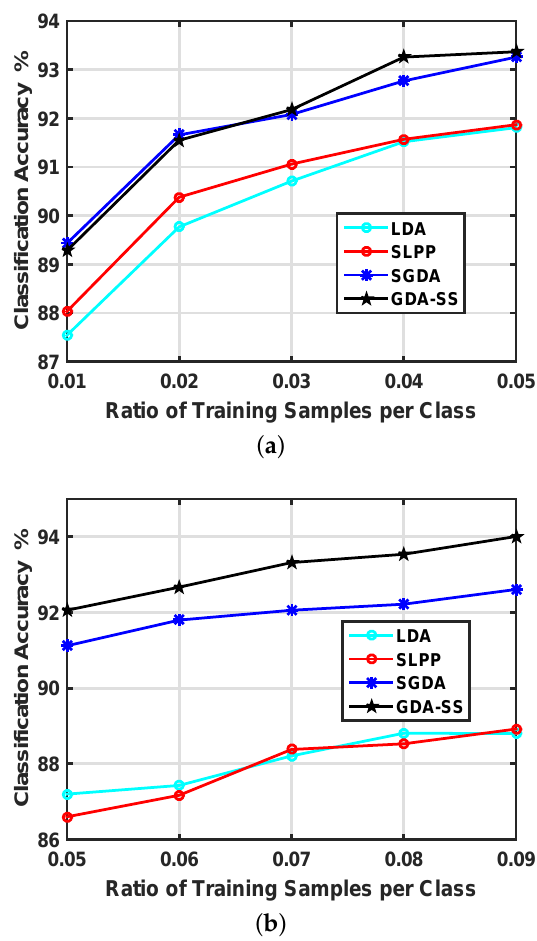
Figure 7. Classification performance of methods with different numbers of training sample sizes using the experimental datasets. ( a ) Salinas; ( b ) Pavia University.